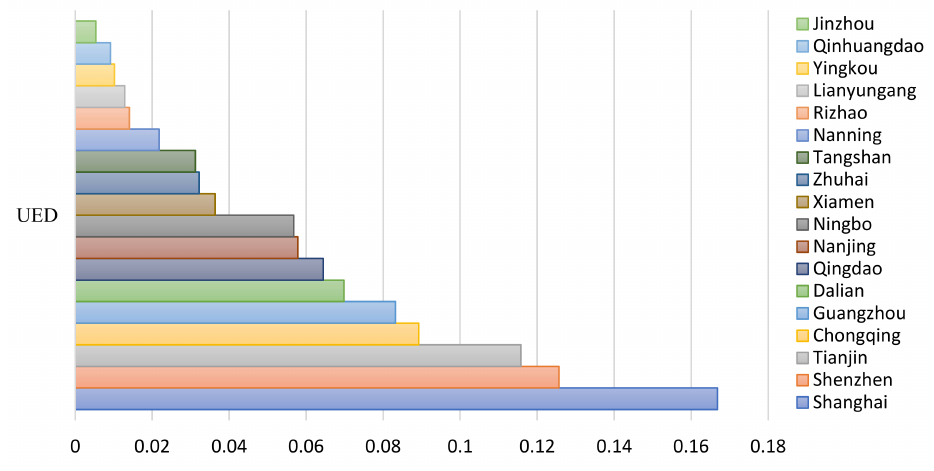
Figure 3. 2011–2018 average for port city’s